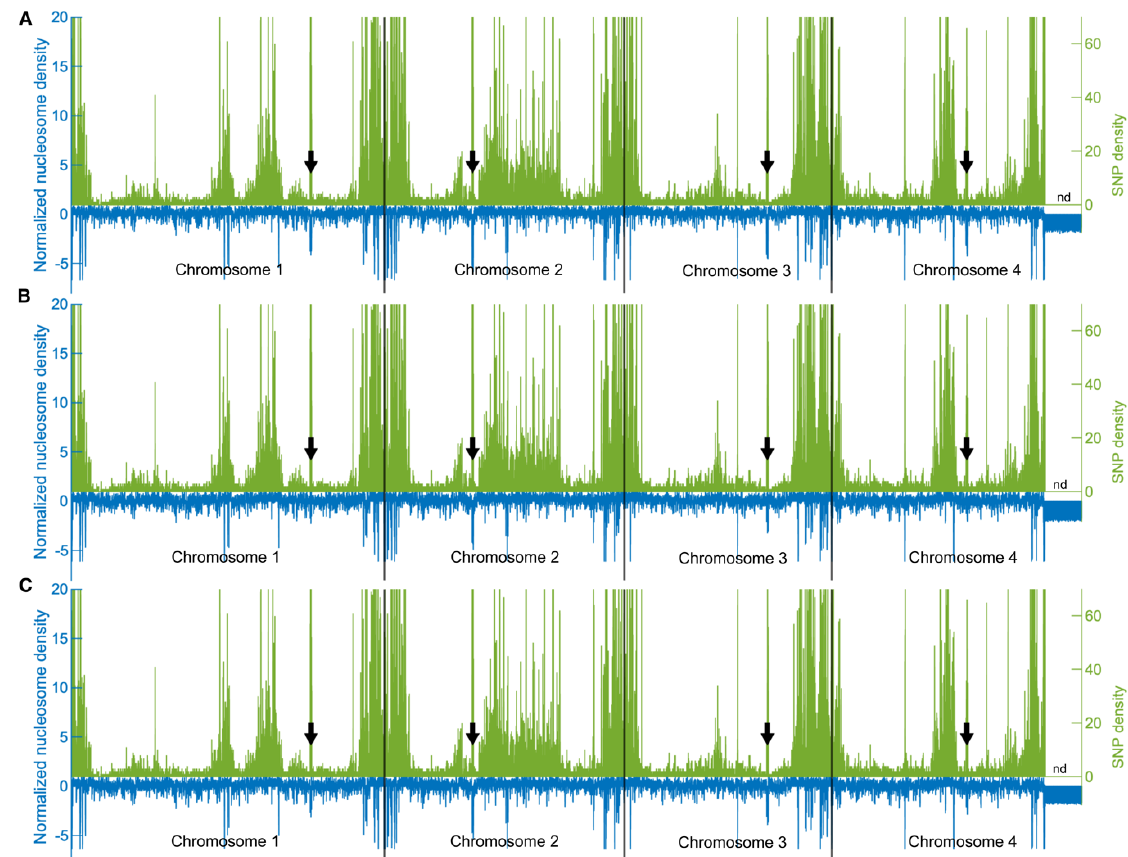
Supplementary Figure 4. Nucleosome vs . SNP density profiles in individual biological replicates of Fusarium graminearum . Coverage density profiles were computed for non-overlapping 1 kb-long bins along the four chromosomes of F. graminearum . In green are plotted SNP density profiles as previously described (Laurent et al. , 2017). “nd” indicates the highly variable 3’ end of chromosome 4 for which SNP were not called. In blue are plotted the z-scored nucleosome density profiles. Black arrows indicate centromeres (King et al. , 2015); ( A) . Biological replicate #1; ( B) . Biological Replicate #2; ( C) . Biological replicate